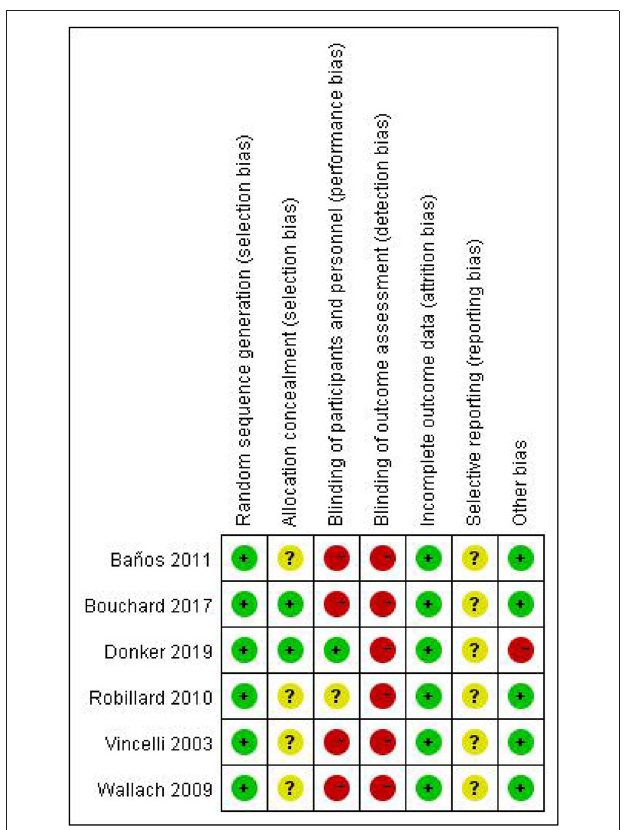
FIGURE 2 | Risk of bias in individual studies. + , low risk of bias; ?, unclear risk of bias; –, high risk of bias.